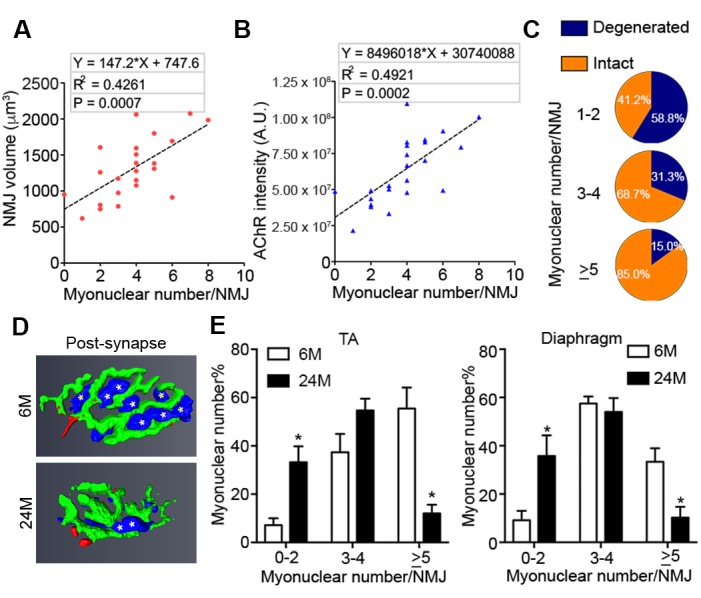
Aged-associated NMJ degeneration is accompanied by reduction in the size of post-synaptic myonuclear clusters.(A–B) Linear regression analysis demonstrates positive correlation between (A) NMJ volume or (B) AChR cumulative intensity (both quantified by Amira using confocal-fluorescent images of individual NMJs) and the post-synaptic myonuclear number. (C) Percentage of pre/post-synaptic degenerated or intact NMJs in groups with different size of post-synaptic myonuclear cluster. (D) 3-D Amira-based reconstructions (viewed from the post-synaptic side) of adult and aged C57BL6/J NMJs stained for post-synaptic AChRs (green), nerve terminal markers (red) and nuclei (blue). Post-synaptic myonuclei are indicated with white asterisks and pre-synaptic nuclei with yellow asterisks. (E) Percentage distribution of NMJs based on number of post-synaptic myonuclei in TA and diaphragm.